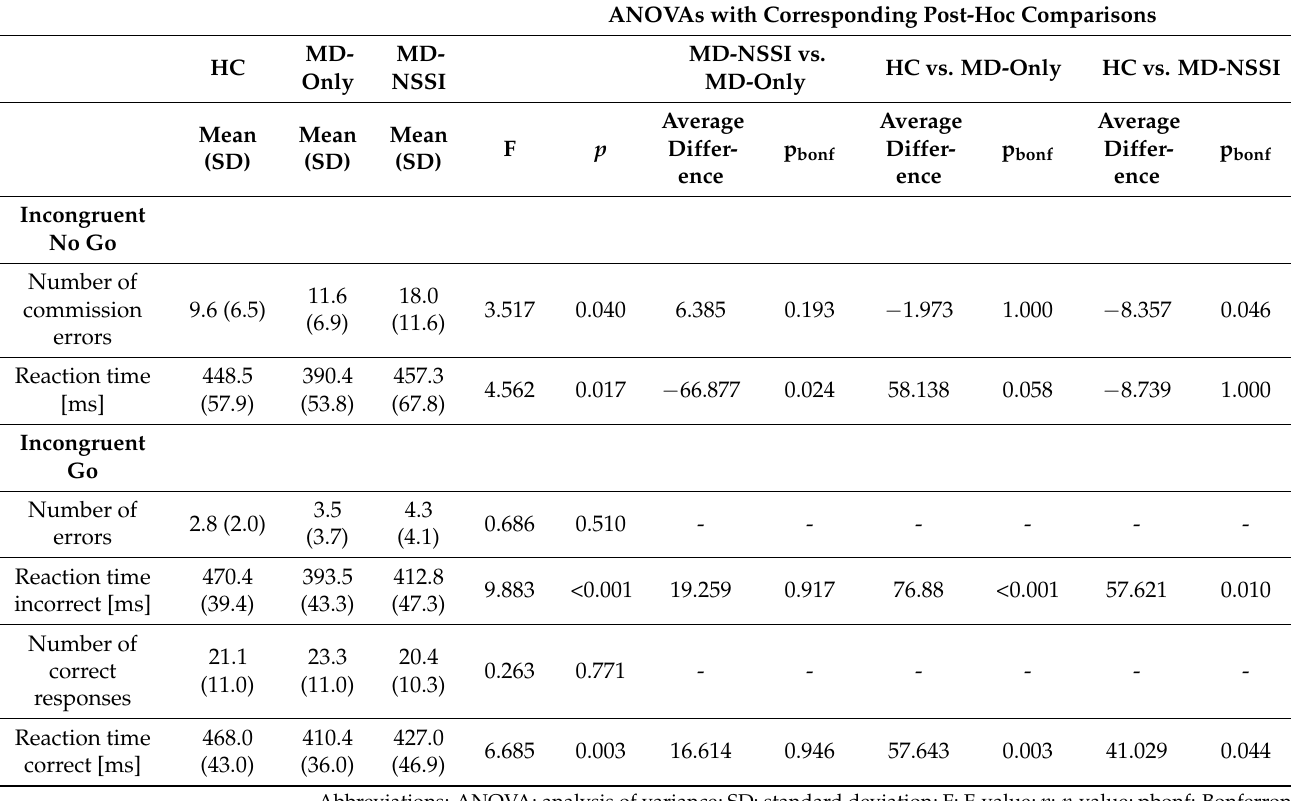
Table 2. Performance data in healthy controls (HC; n = 14), adolescents with major depression (MD-only; n = 13), and depressed adolescents with comorbid non-suicidal self-injury (MD-NSSI; n = 14). Group differences were calculated with ANOVAs, followed by Bonferroni-corrected post-hoc comparisons at an alpha level of p ≤